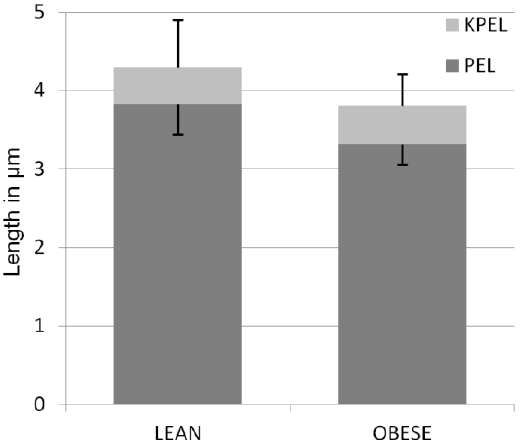
Figure 1. Mean length (±SD) of primary epidermal lamellae (PEL) and keratinized epidermal lamellae (KPEL) in the hooves of lean and obese horses. The difference in PEL length between groups is significant ( p < 0.001).